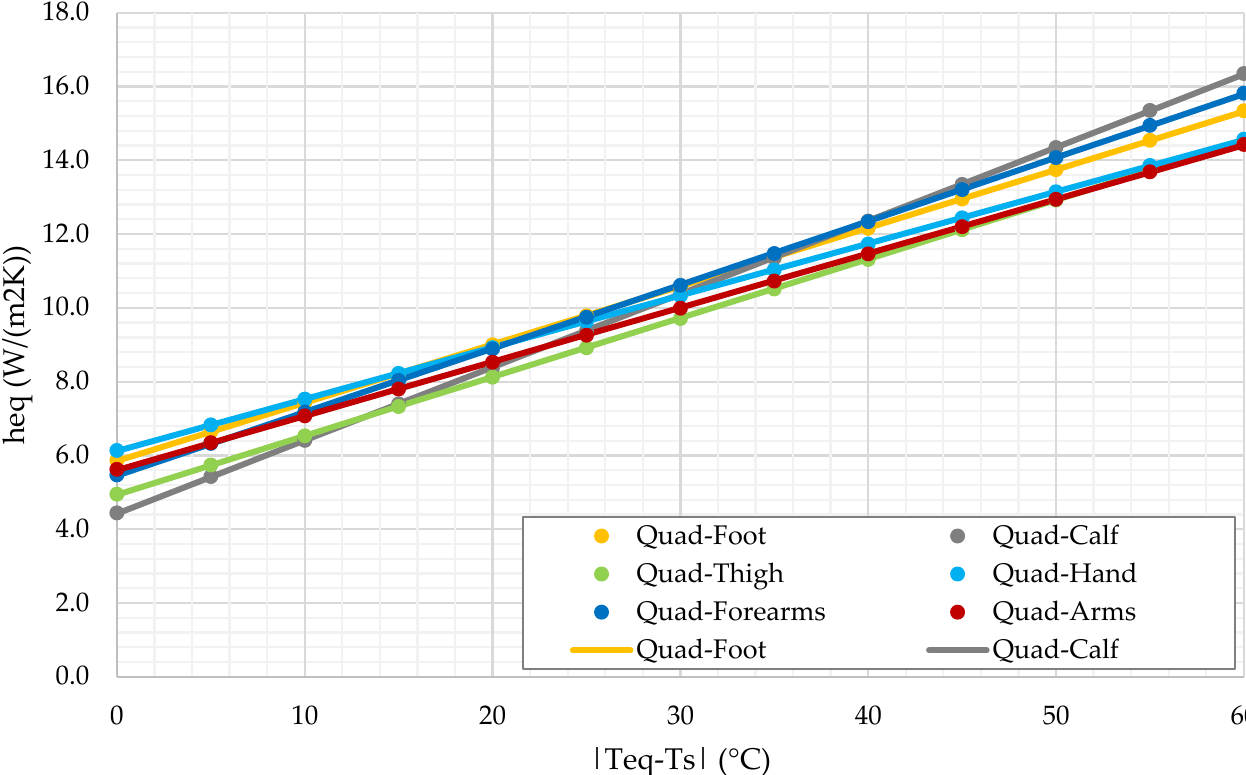
Figure 8. h eq linear relation for body segments group 1.